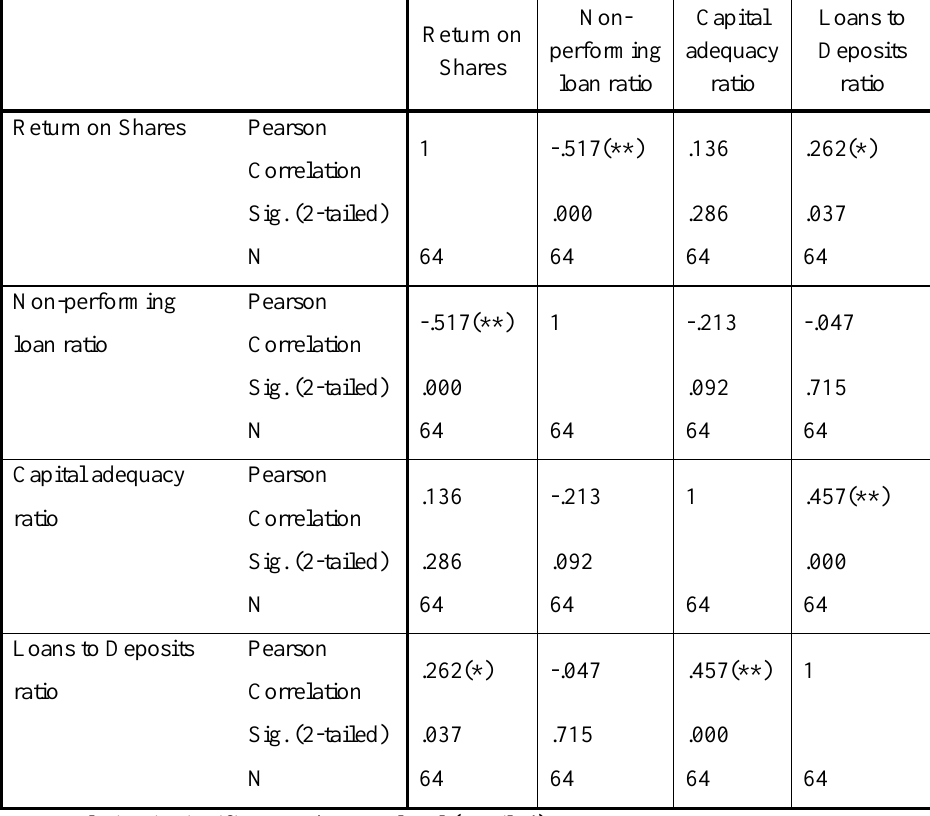
Table 04: Correlation Matrix Return on